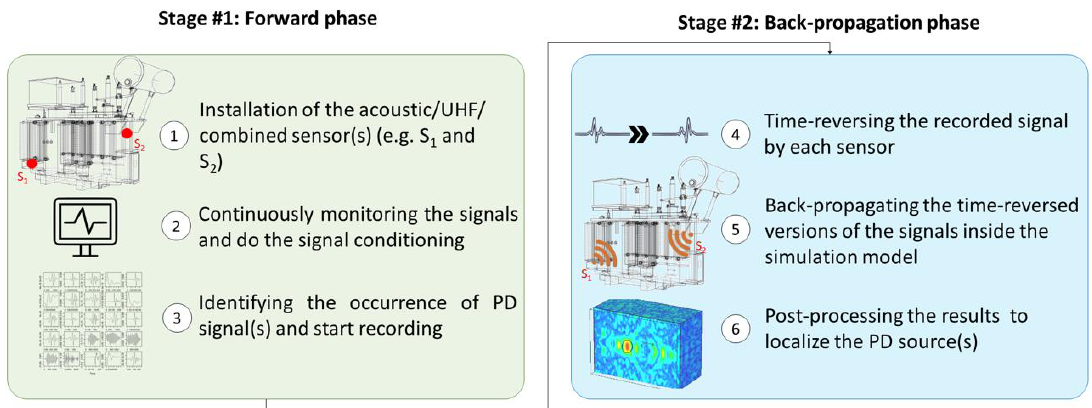
Figure 1. Schematic view of the proposed partial discharge (PD) localization approach based on the TR method.